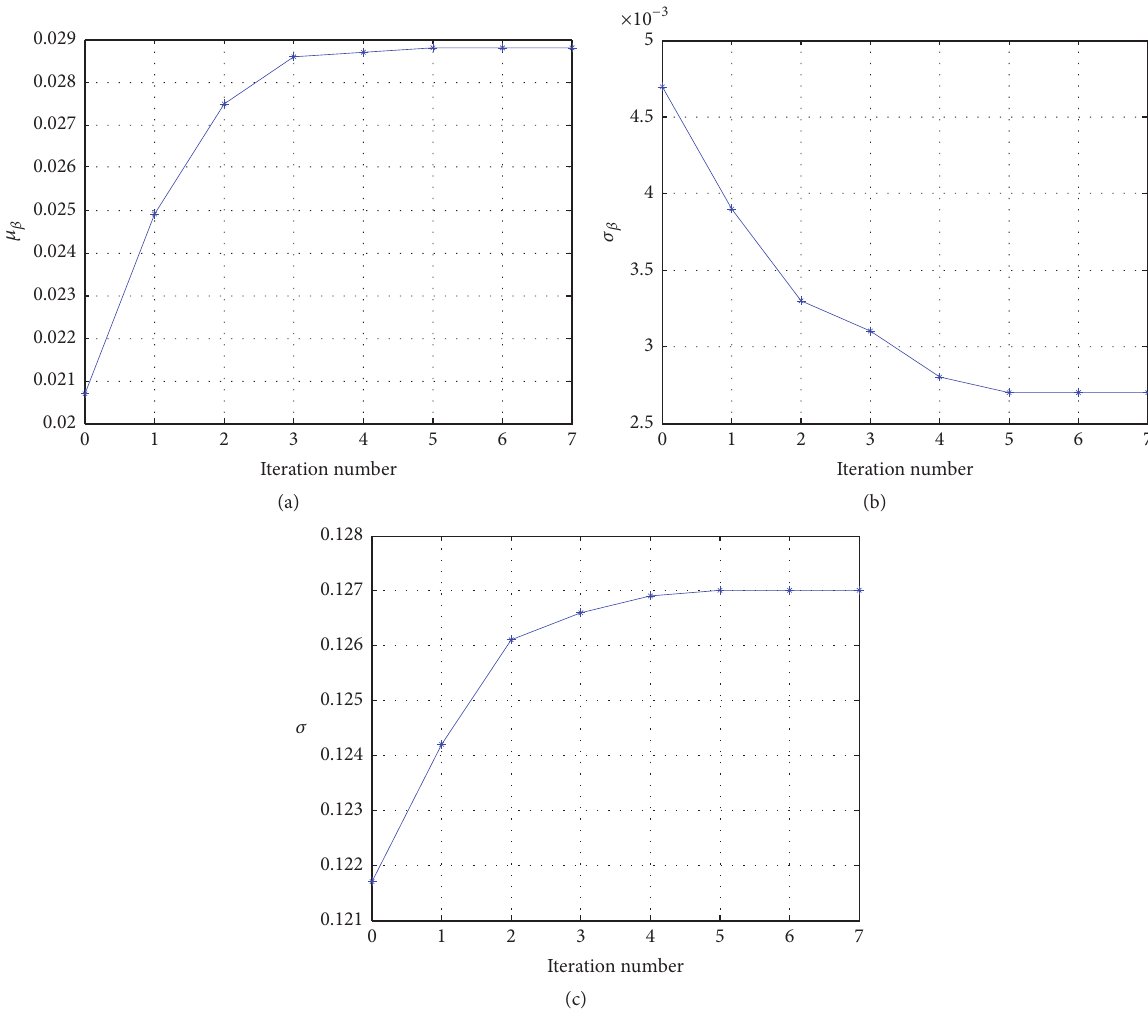
Figure 14: Parameter estimation: (a) 𝜇 𝛽 , (b) 𝜎 𝛽 , and (c) 𝜎 .